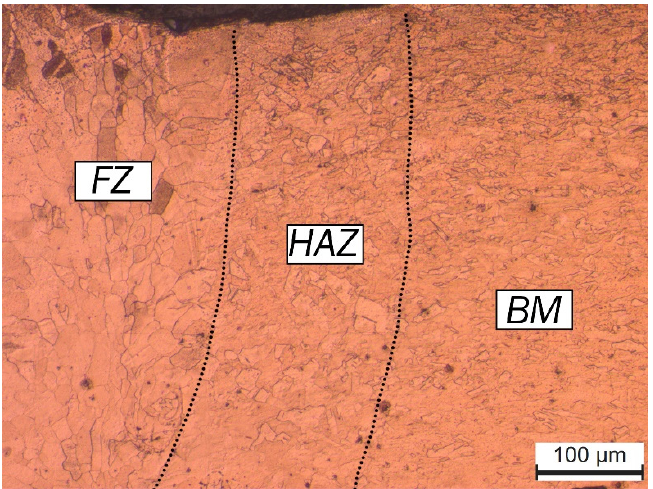
Figure 11. Optical micrograph of the weld region in top sheet of copper-to-copper joint made with an oscillation amplitude of 0.2 mm and an oscillation frequency of 100 Hz showing FZ, HAZ, and BM.